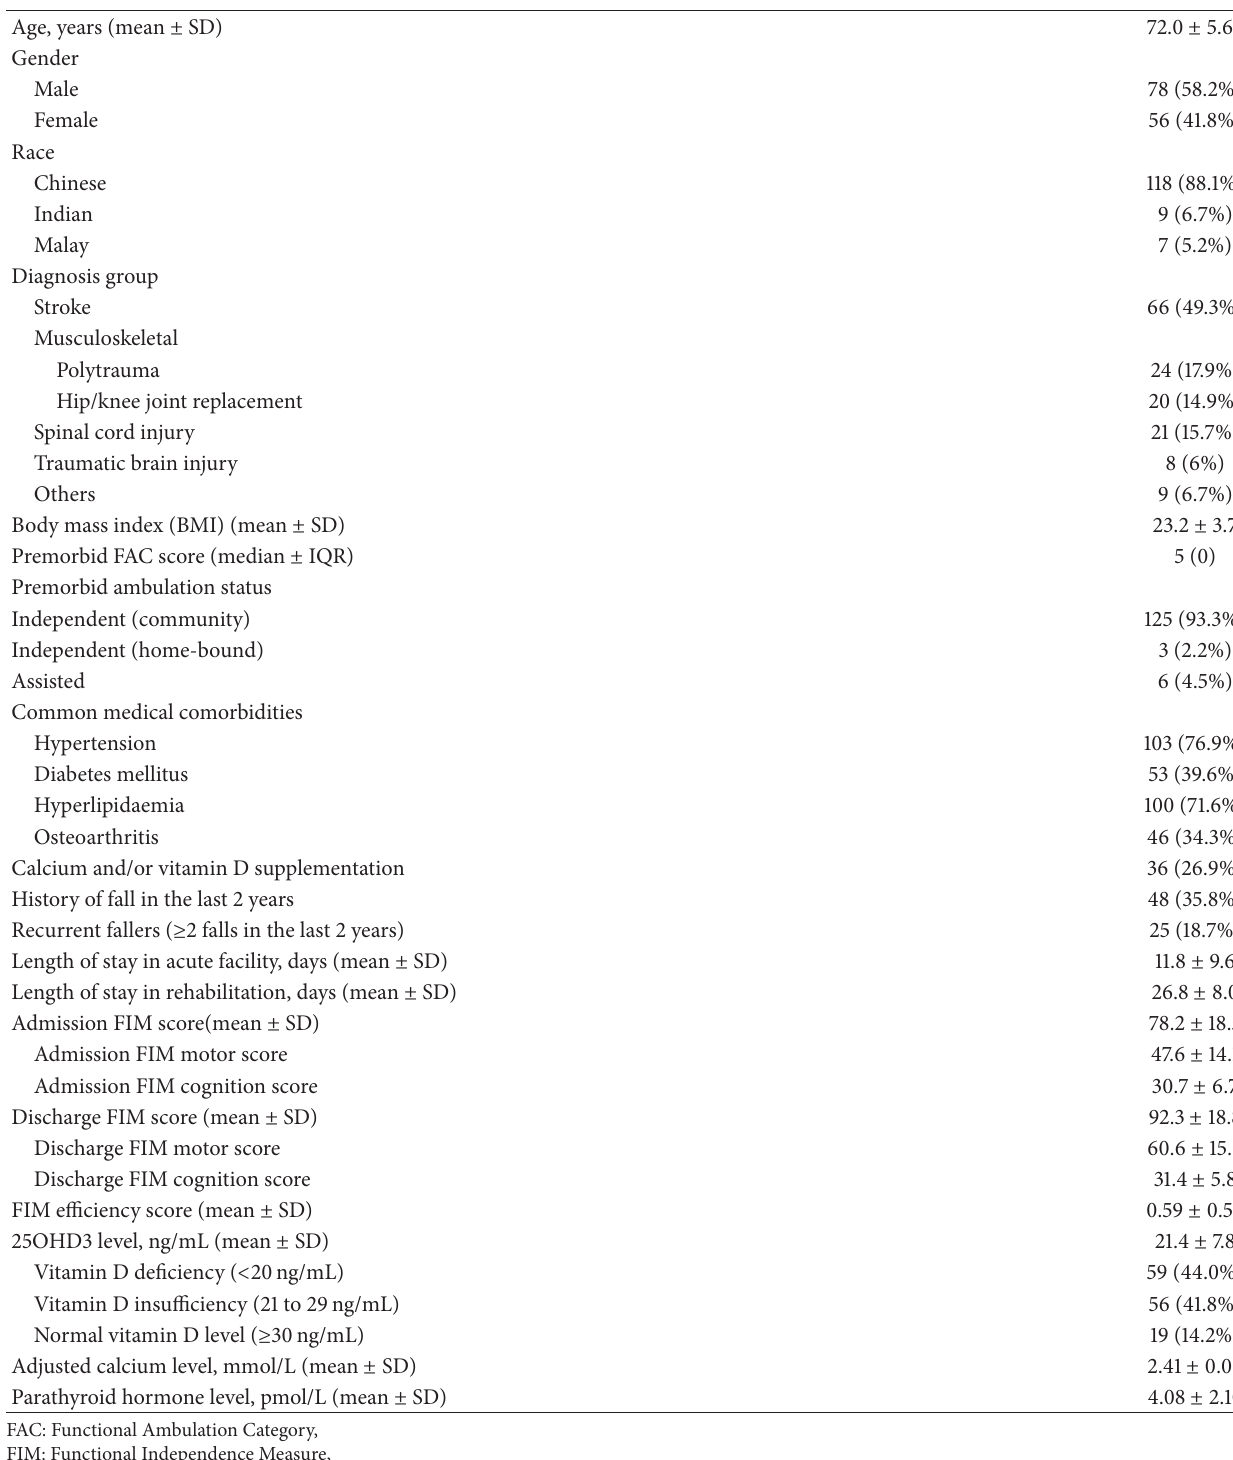
Table 1: Baseline characteristics of